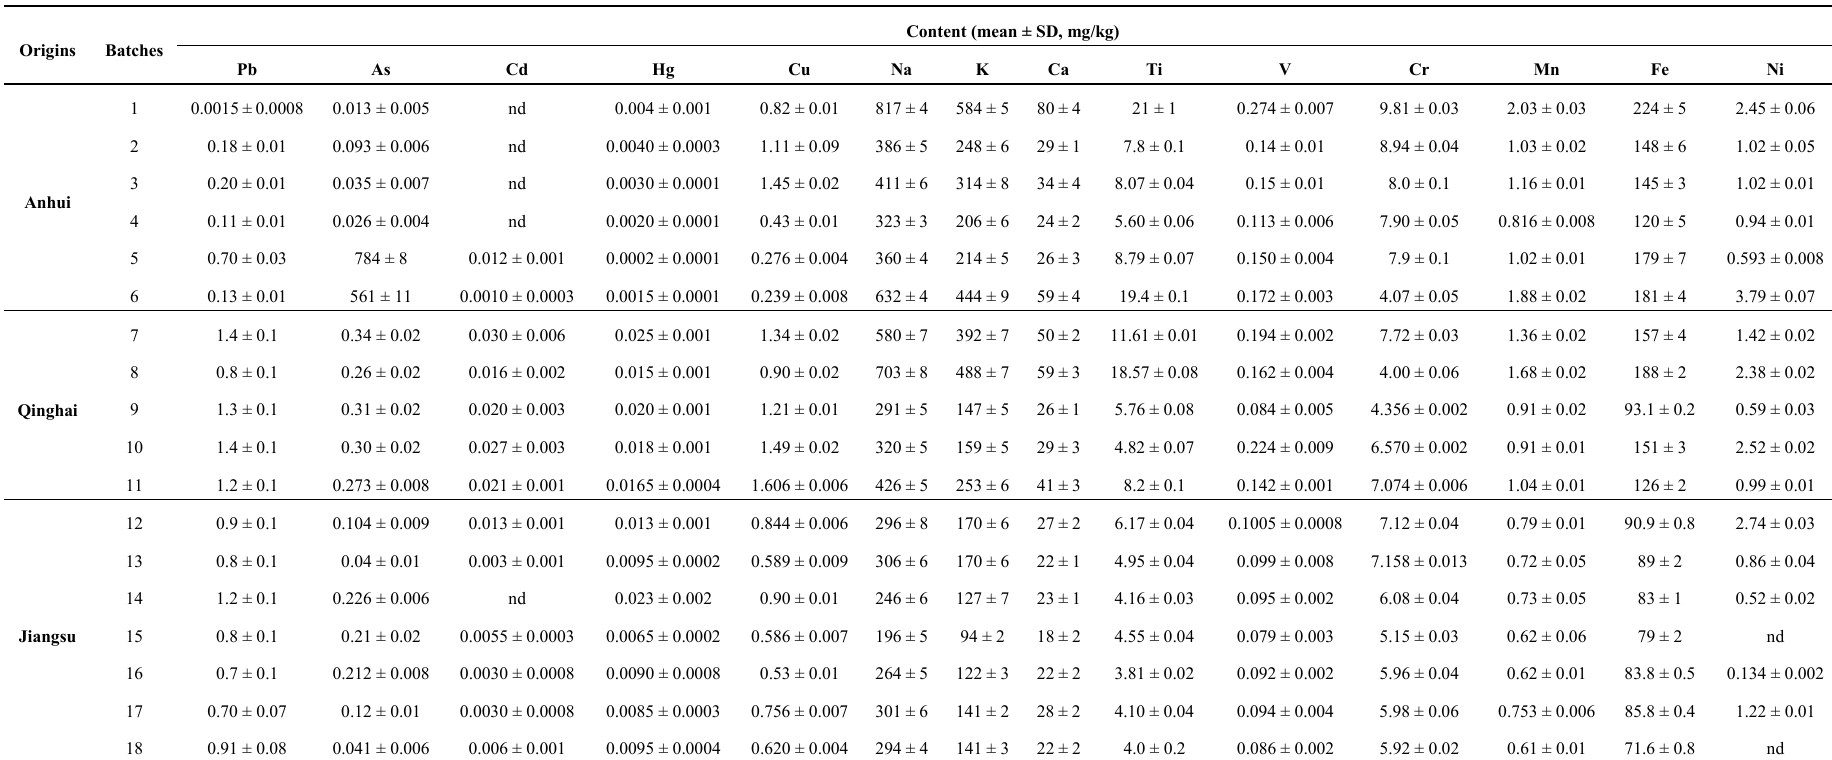
Table 4. Contents of 14 types elements in 18 batchs of suet oil (n =